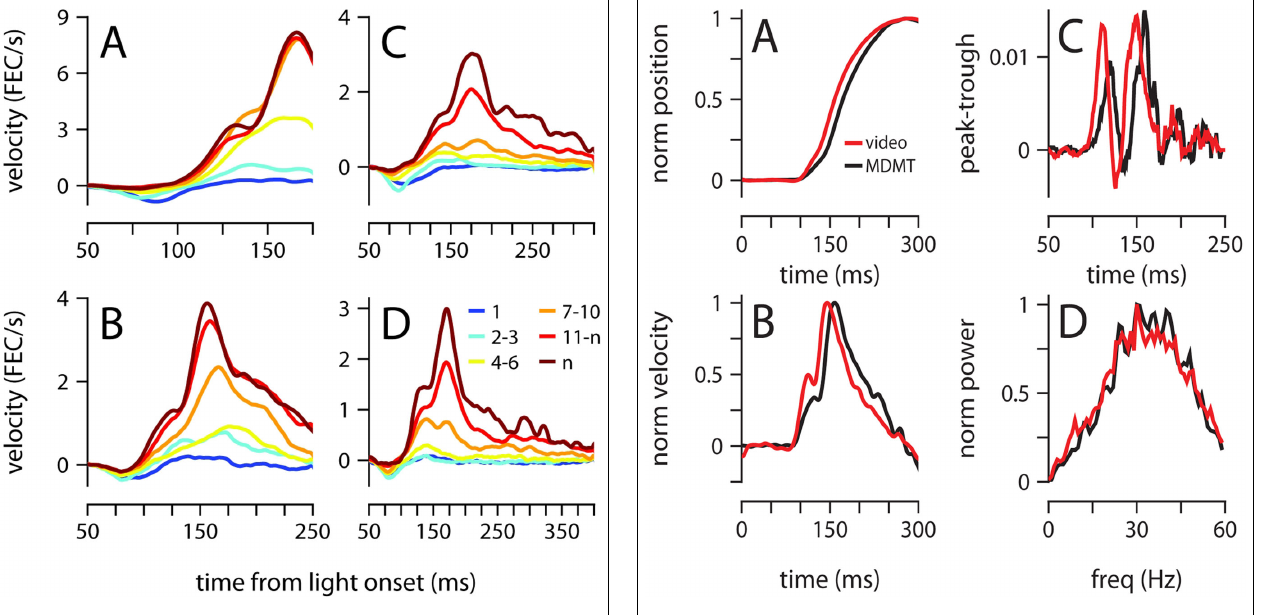
FIGURE 8 | Comparison of video and MDMT. (A) Normalized average position, and (B) normalized average velocity. (C) Difference between the probability of finding a peak and a trough at each millisecond from light onset. (D) Normalized average power spectrum of eyelid acceleration. Color code for all plots indicates the type of recording system and is shown in (A) . All data is from two 300-trial sessions with a mouse trained with a 250-ms